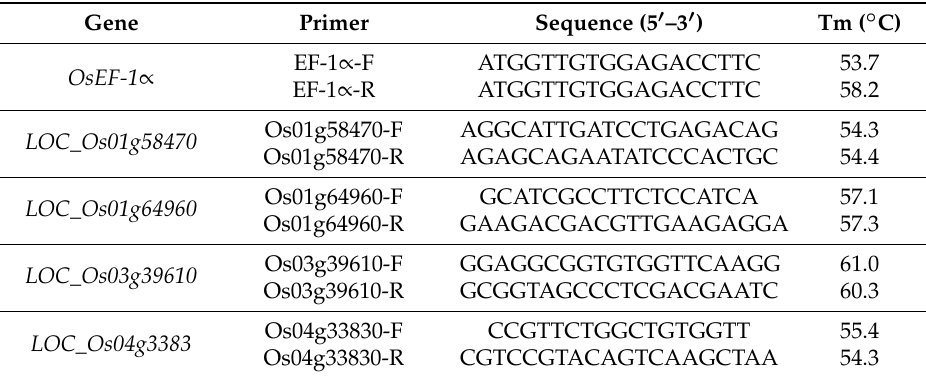
Table 2. Primers for gene expression